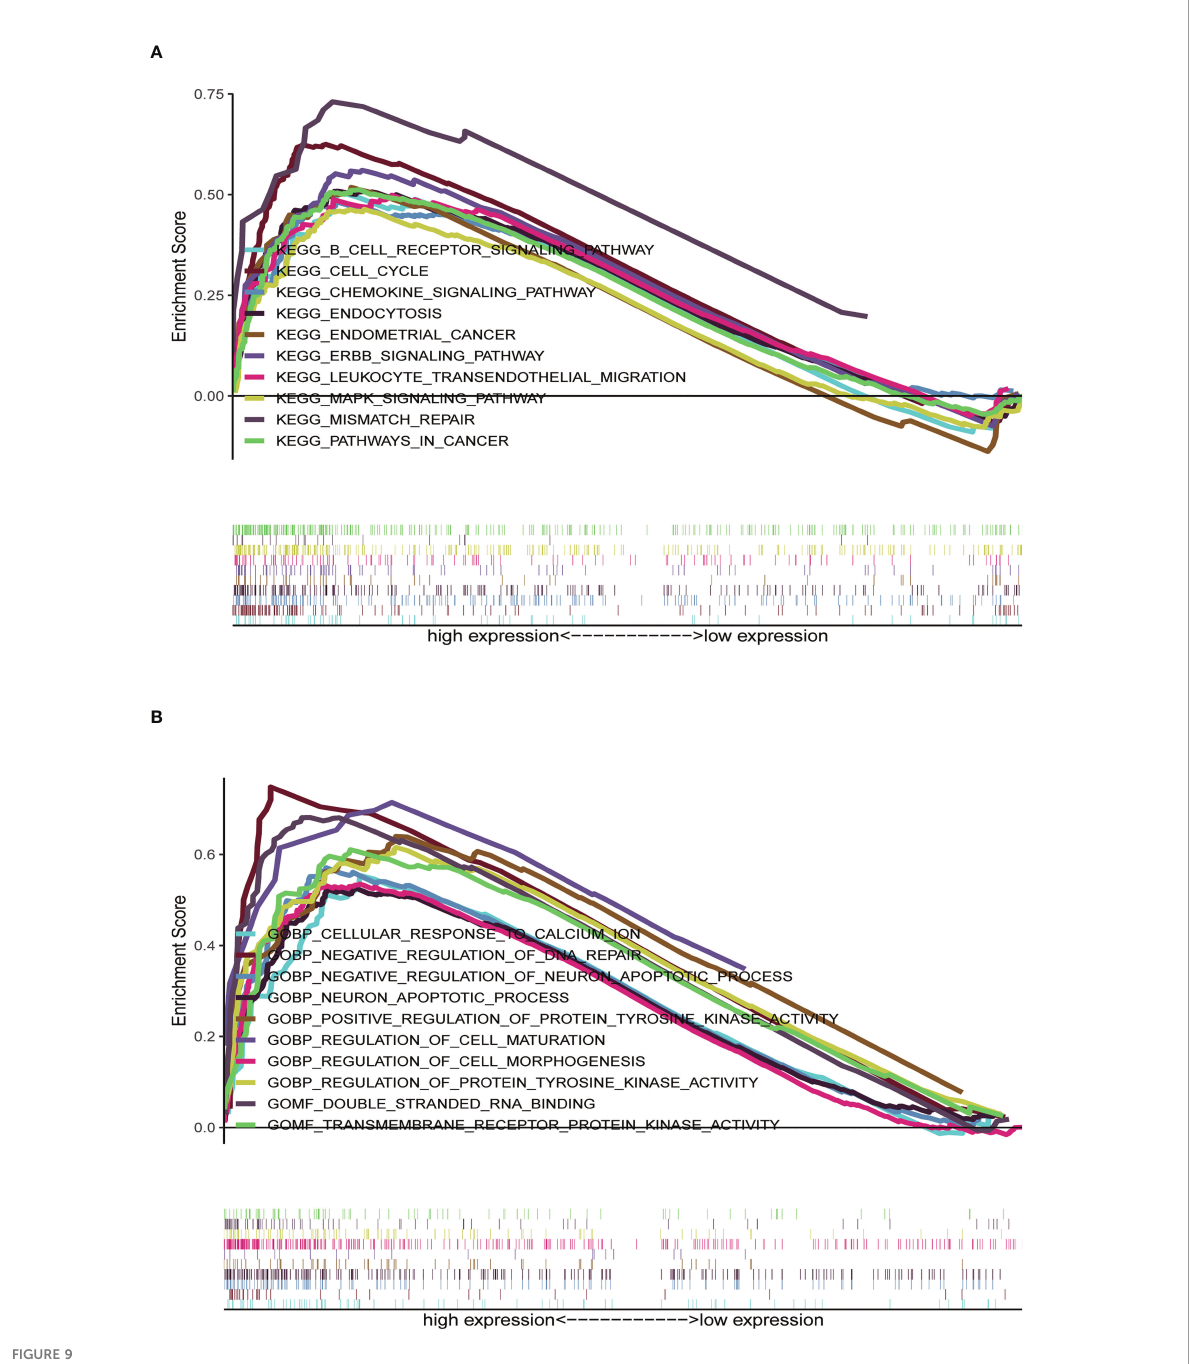
FIGURE 9 Gene set enrichment analysis (GSEA) between high- and low-risk groups. (A) KEGG enrichment analysis of the high- and low-risk groups. (B) GO enrichment analysis of the high- and low-risk